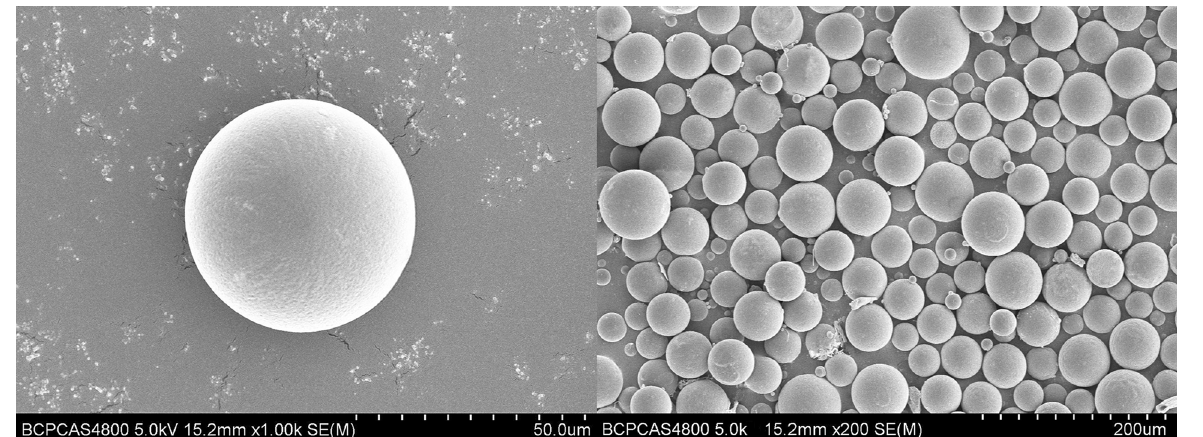
Fig 1. Scanning electron micrographs of nalmefene loaded PLGA microspheres.